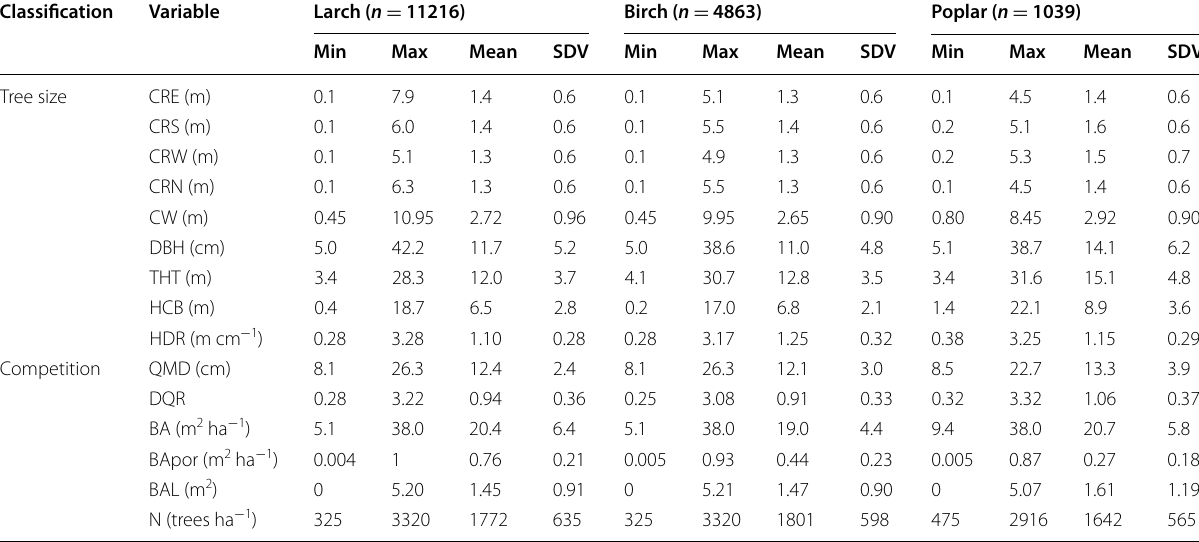
Note : CRE east crown radius, CRS south crown radius, CRW west crown radius, CRN = = = breast height, THT total height, HCB height to crown base, HDR THT-to-DBH ratio, QMD = = = area, BApor basal area proportion of target species, BAL the basal area of trees larger than the subject tree, N = = maximum value, Mean average value, and SDV standard = = =